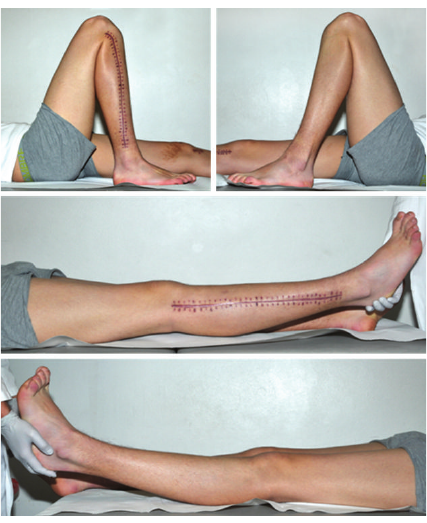
Figure 5: After implant removal, ROM of the knee was 0/0/150 ∘ on the right side and 10/0/135 ∘ on the left